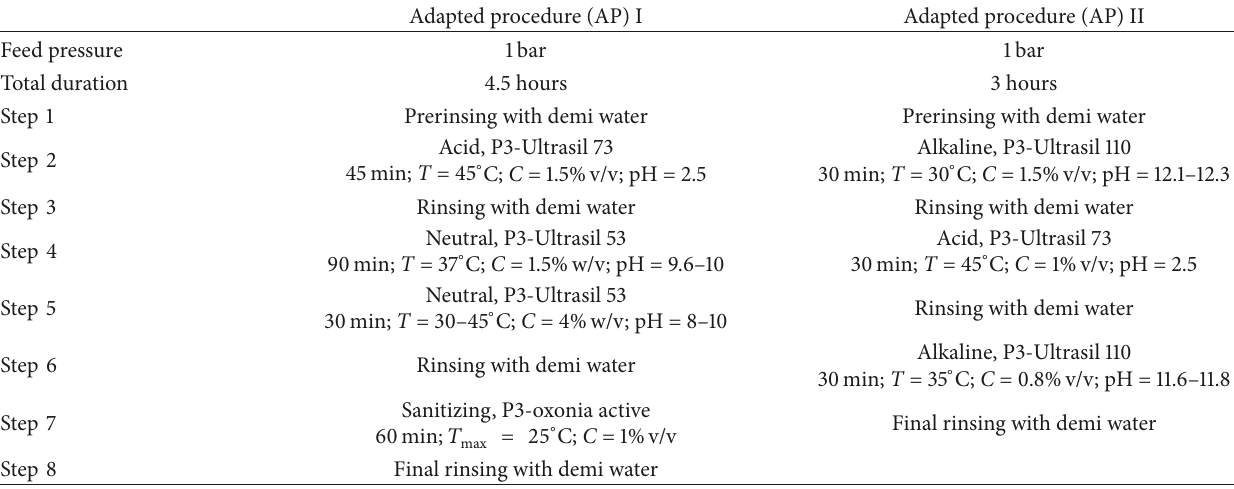
Table 3: CIP procedures for (bio)organic fouling removal at laboratory